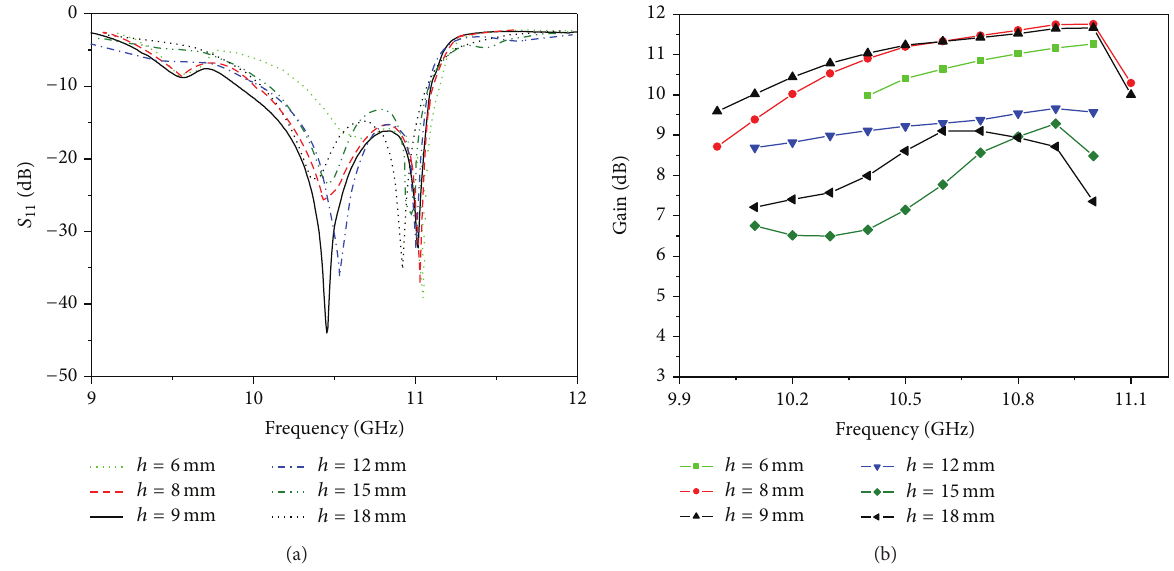
Figure 6: The performance of the proposed wideband antenna with the ZIM cover for different distances ℎ , (a) the reflection coefficients and (b) the antenna